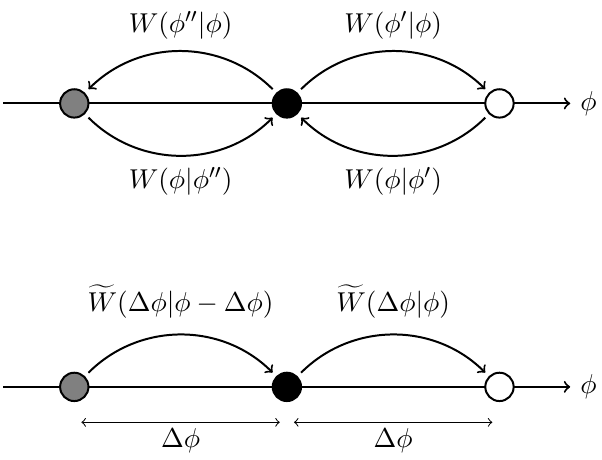
Figure 1 . Visualization of the Kramers-Moyal expansion. The top panel shows the probability of “hopping” from φ to φ 0 , W ( φ 0 | φ ) or from φ 0 to φ , W ( φ | φ 0 ) , or equivalently any other point such as φ 00 . On the bottom, we see the process in terms of the probability f W (∆ φ | φ ) to hop from a specific starting point φ by a distance ∆ φ